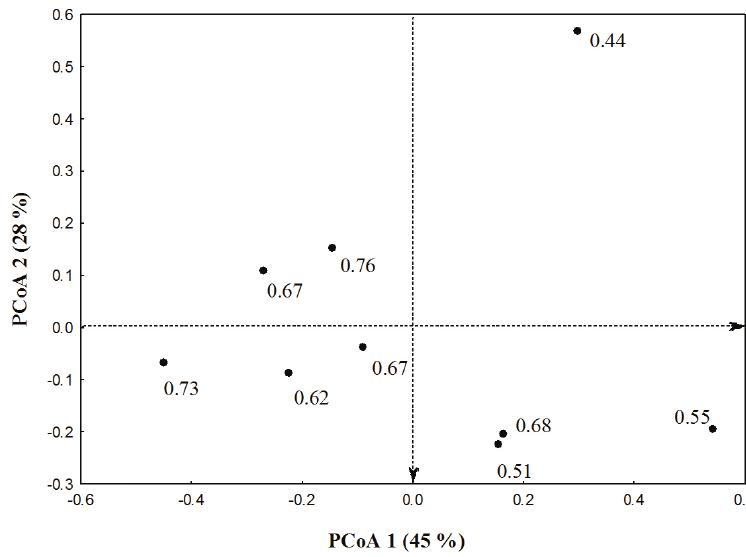
Figure 2. Ordination plot of community similarity of damselflies in nine streams in southern Amazon, Querência municipality, Mato Grosso State, Brazil. The numbers refer to the Habitat Integrity Index (HII, Nessimian et al., 2008) of each transect.